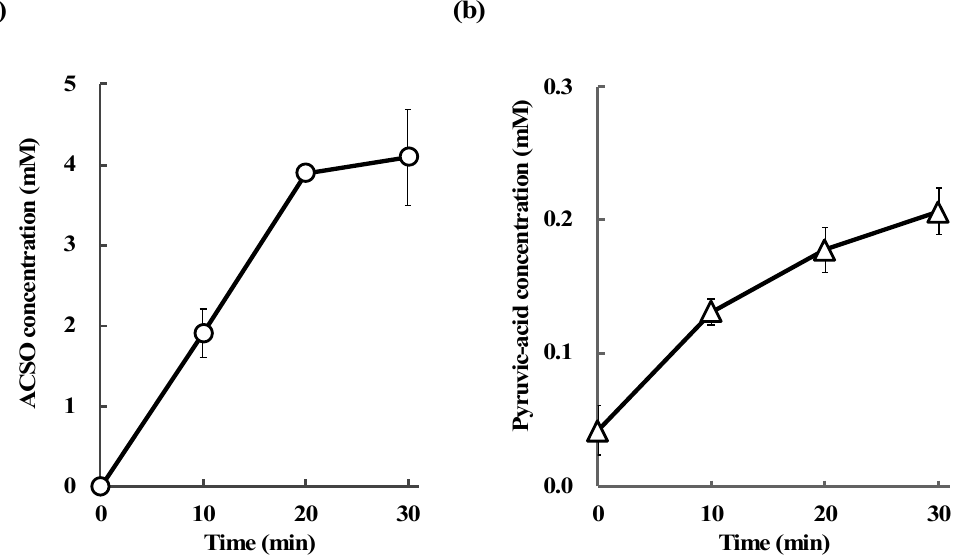
Figure 7. ACSO ( a ) and pyruvic-acid ( b ) concentrations in the portal vein were measured after injection of ACSO into the small intestine. Each value represents the mean of three excited small intestines ± S.E. Table 1. ACSO and pyruvic-acid concentrations in rat small intestines 30 min after injection of ACSO or PBS into the small intestine.